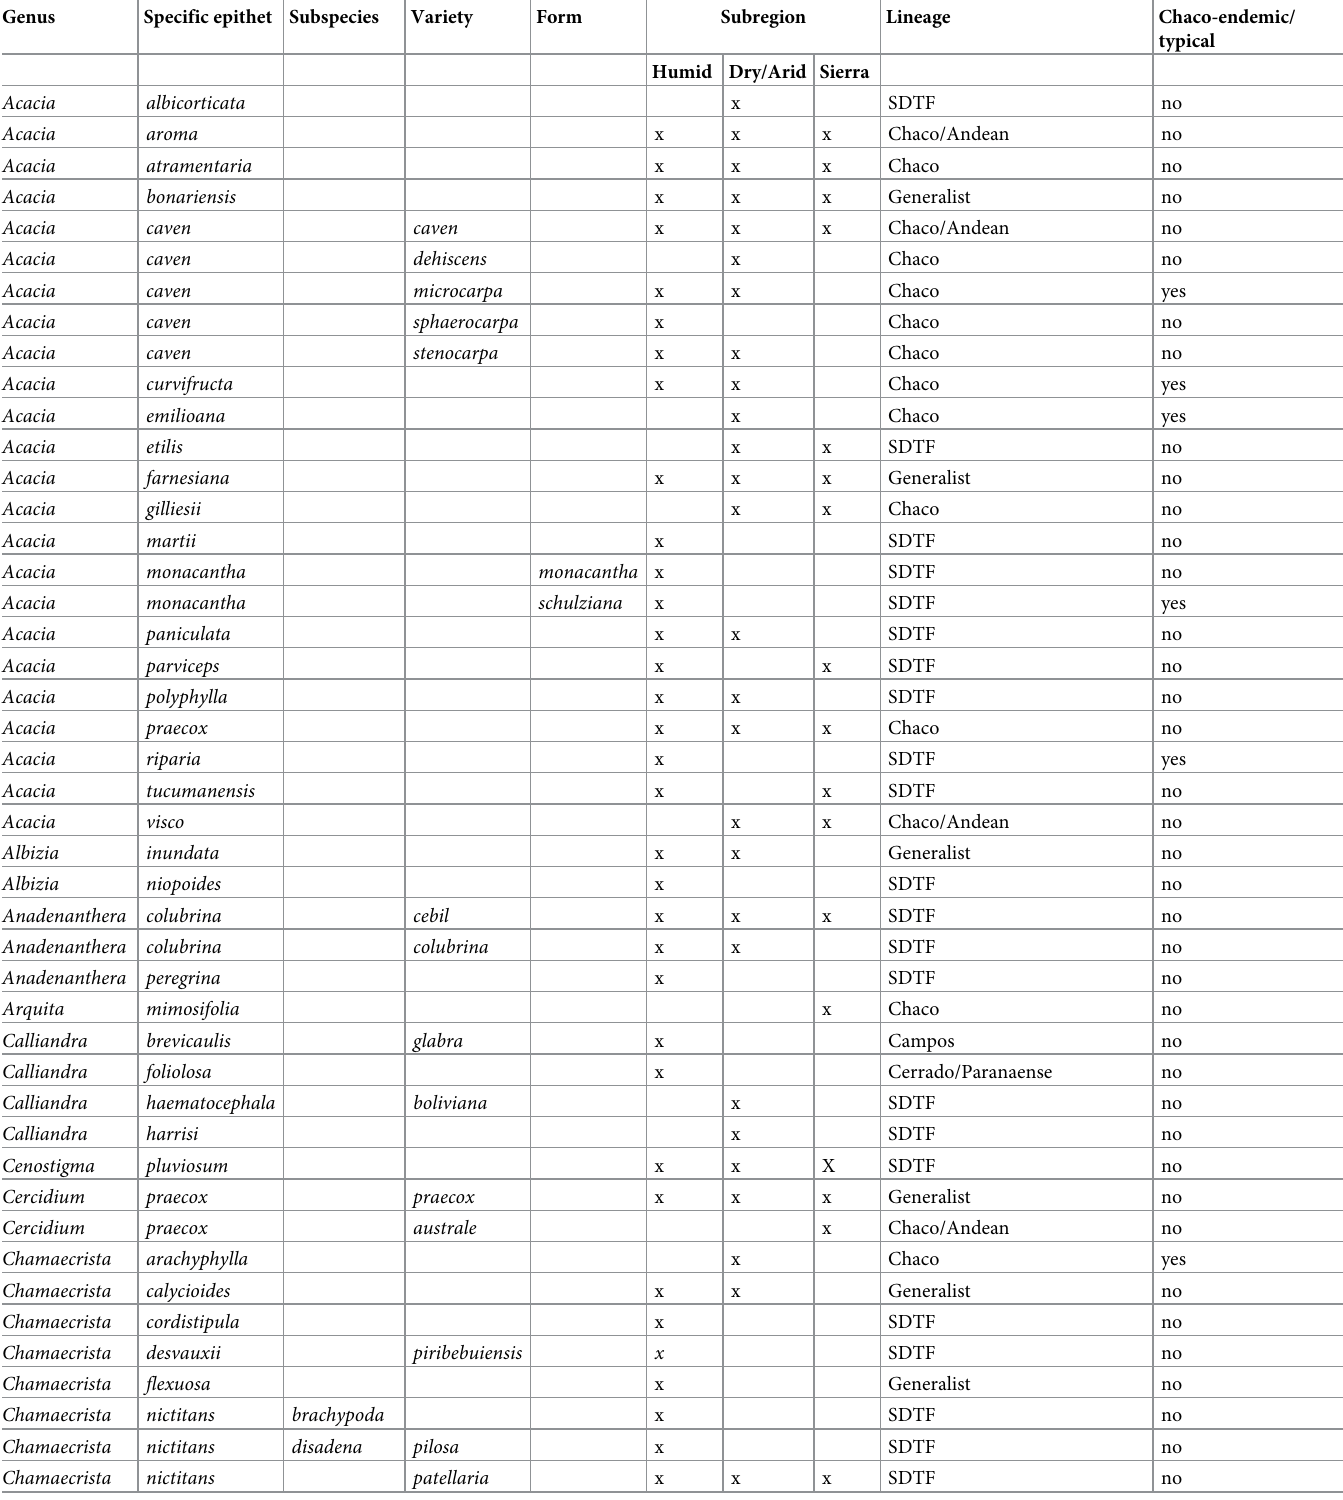
Table 4. Checklist of species and infraspecific taxa of Caesalpinioideae subfamily, their distribution in Chaco, lineage and endemism.